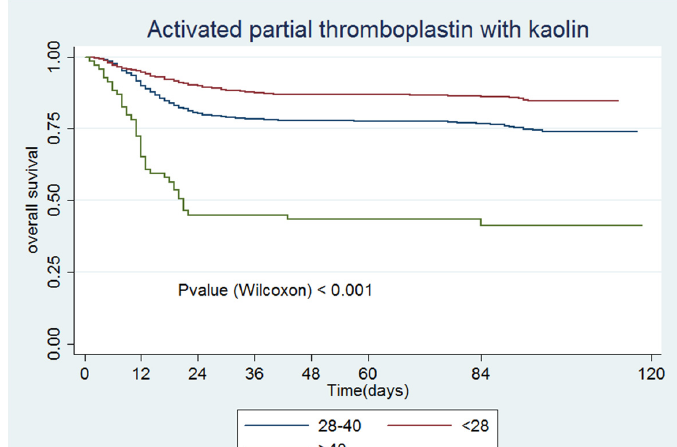
Figure 3. Fibrinogen.